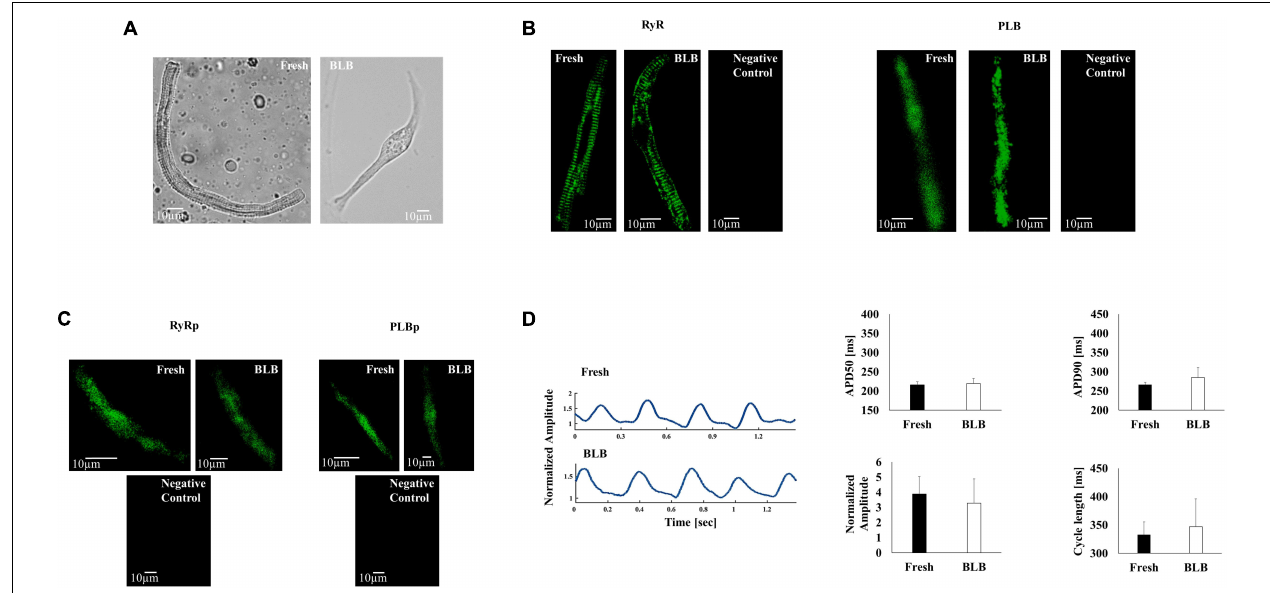
FIGURE 2 | Pacemaker cell culture. (A) Representative examples of fresh and cultured pacemaker cells. (B) Representative examples of ryanodine receptor and PLB immunolabeling in fresh and cultured pacemaker cells (No first antibody was added to the negative control). (C) Representative examples of the phosphorylation status immunolabeling of the ryanodine receptors and SERCA in fresh and cultured pacemaker cells. (D) Representative examples of action potential in fresh and cultured pacemaker cells and average data for action potential characteristics (APD50, APD90, normalized amplitude, and cycle length). Data are from Segal et al. (2019). Animals were treated in accordance with the Technion Ethics Committee. The experimental protocols were approved by the Animal Care and Use Committee of Technion (Ethics number: IL-118-10-13).